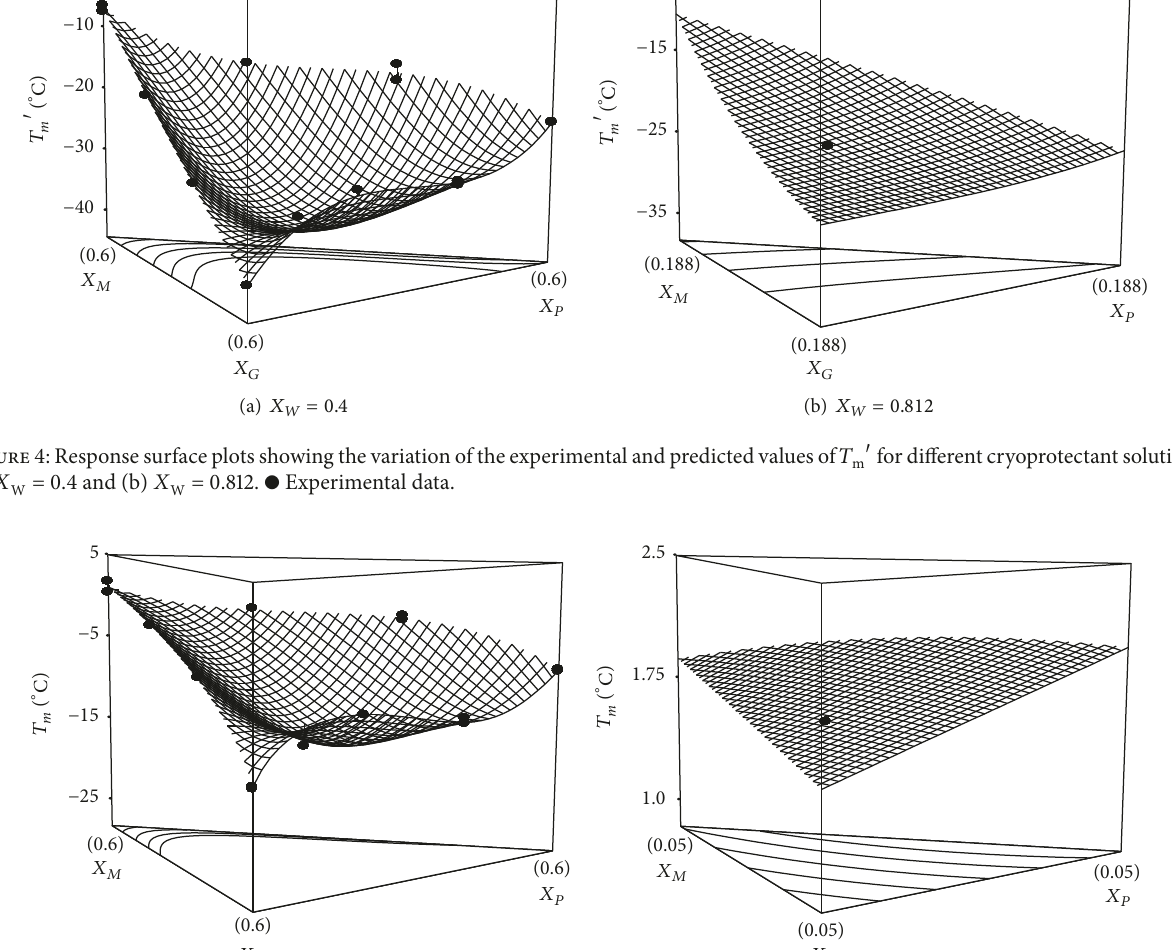
for different cryoprotectant solutions: m